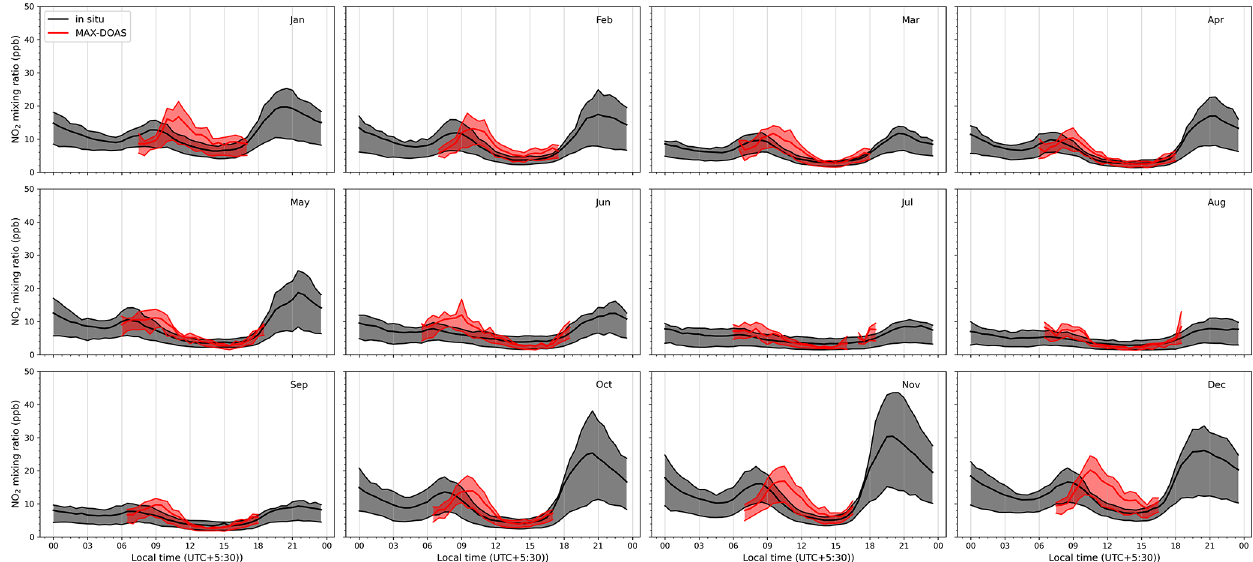
Figure F7. Mean diurnal profiles of surface NO 2 mixing ratios measured by an in situ analyser (black) and retrieved from the MAX-DOAS measurements (red) for different months of the year. The dark line represents the mean value, while the shaded region above and below the dark lines represent the 75th and 25th percentiles, respectively.